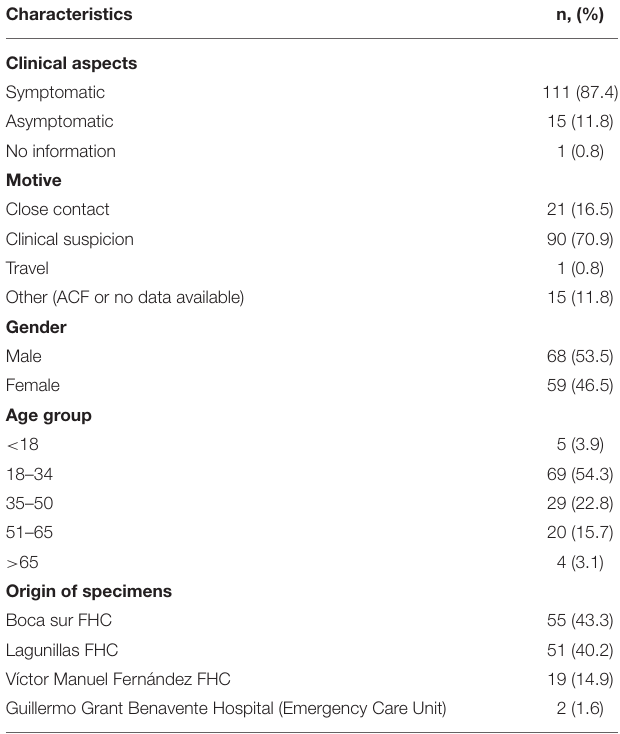
TABLE 1 | Demographic characteristics of the